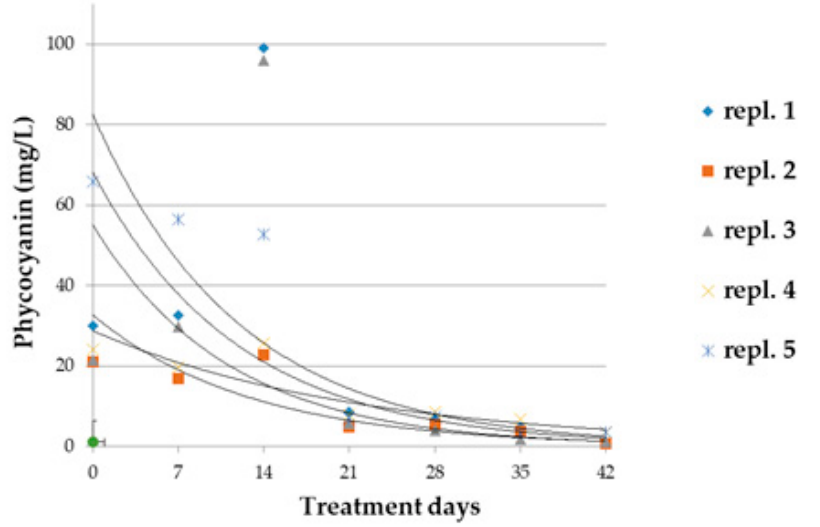
Figure 7. Phycocyanin concentration in biological replicates ( n = 5) of A. maxima cultivations treated with 0.2 mM glyphosate for 42 days. Mean concentration values ( ± ES) of phycocyanin and the regression line (dotted line) of the reference samples have been also reported. Regression lines were calculated for each group of samples. Statistical data and parameters are reported in Supplementary Table S1I.